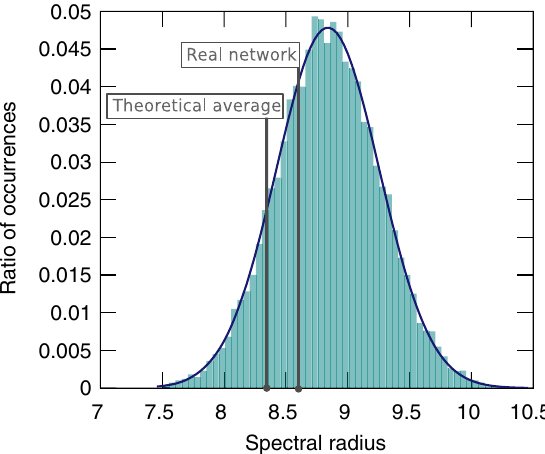
FIG. 5. Distribution of the spectral radius over the ensemble calculated for the real network collected by Small [50] for a sampling made of 10 4 networks. In blue, the fit of a Gaussian function using the mean and standard deviation extracted from the distribution (mean μ ¼ 8 . 8 and standard deviation σ ¼ 0 . 4 ). In gray, the values of the nestedness of the real network and of the theoretical average, which correspond to the average computed using the theoretical expression in Eq.